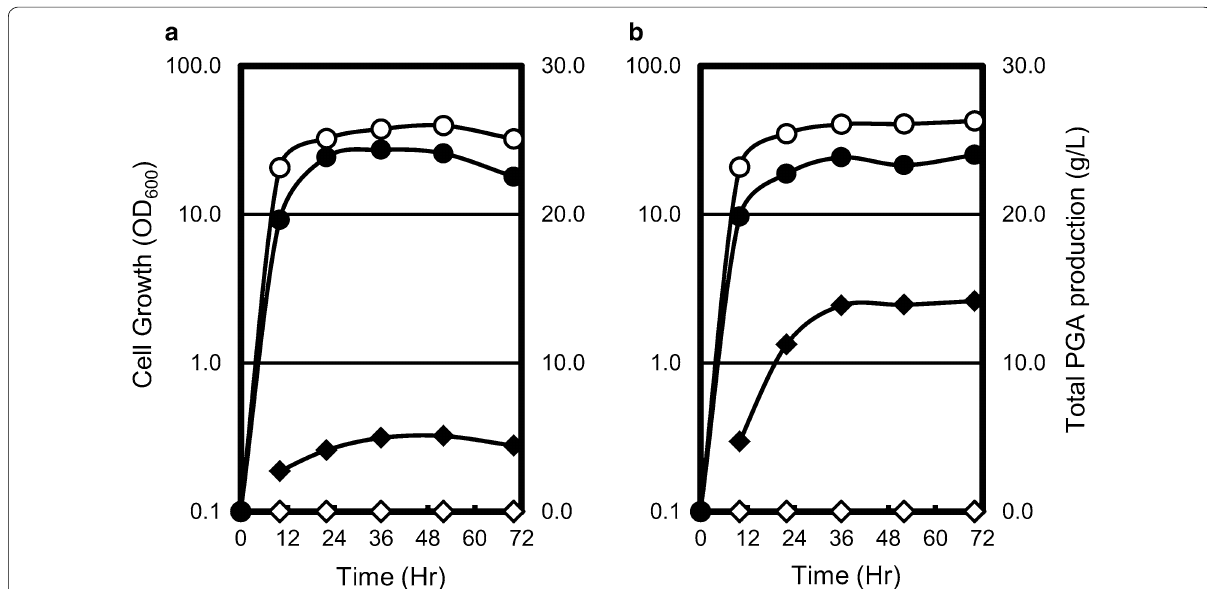
Fig. 2 Time course of PGA production by a P_300/ ∆ 3 and P_BC/ ∆ 3 in 2xL/Mal medium and b P_300/ ∆ 3 and P_BC/ ∆ 3 in 2xL/Mal are presented as means of five independent experiments. Symbols: opened circles, cell growth of P_300/ ∆ 3; opened diamonds, PGA production by P_300/ ∆ 3; closed circles, cell growth of P_BC/ ∆ 3; closed diamonds, PGA production by P_BC ∆